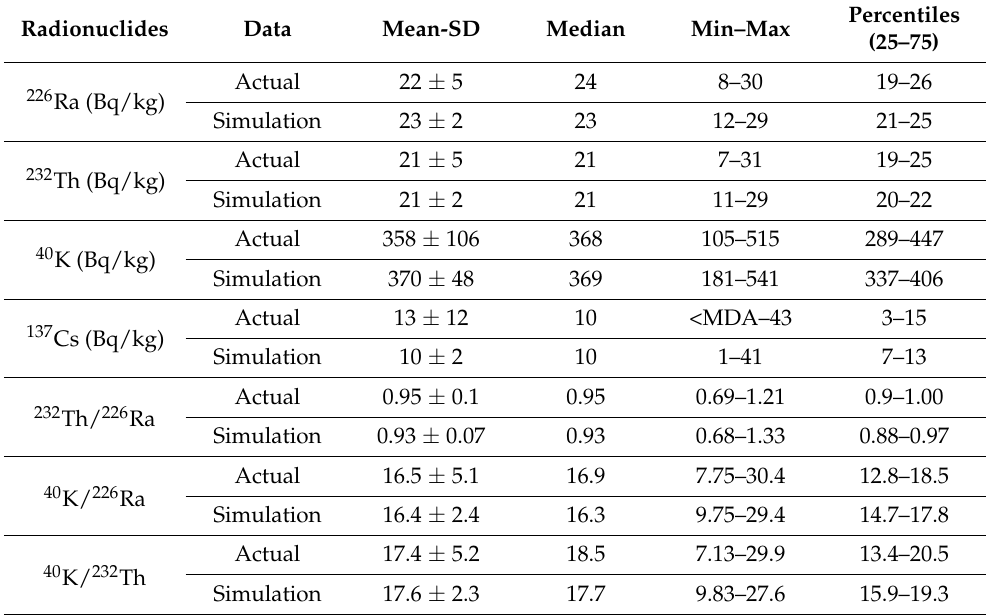
Table 2. Statistics of the actual measurement and simulation of radionuclide activity concentrations in the soil of